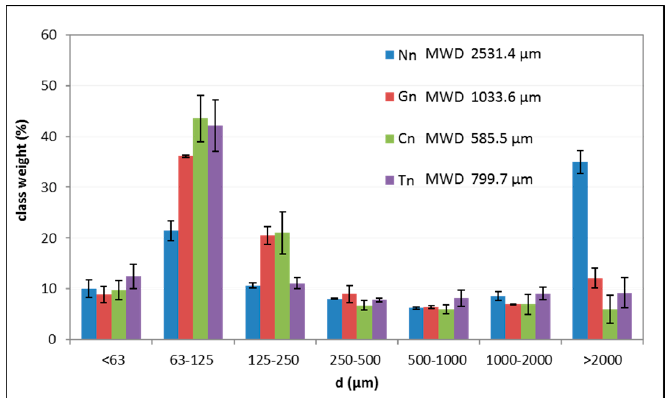
Figure 3. Aggregate size distribution (ASD) in the land use areas: natural area (Nn), grazing (Gn), conventional agriculture practice (Cn), and traditional agriculture practice (Tn). The mean weight diameter (MWD) for each ASD is presented at the upper right corner (from Swet and Katra, 2016 [11]).